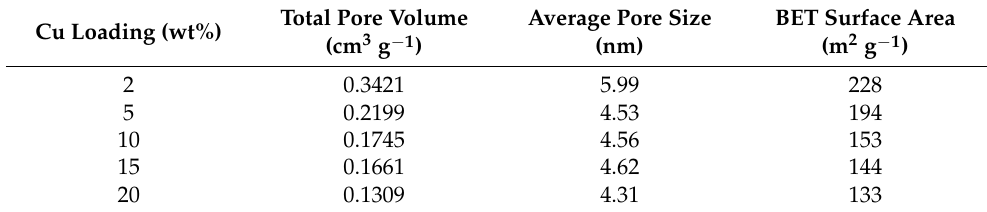
Table 1. Textural properties of various Cu/SiO 2